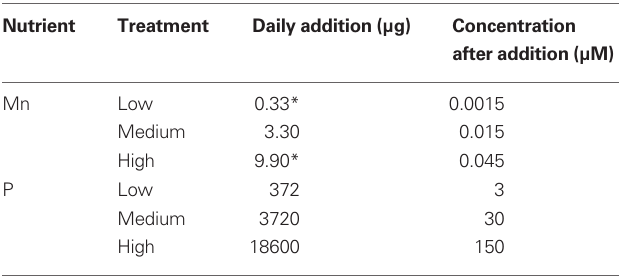
Table 1 | Daily addition rates of phosphorus and manganese per cultivation unit with four plants in the hydroponic